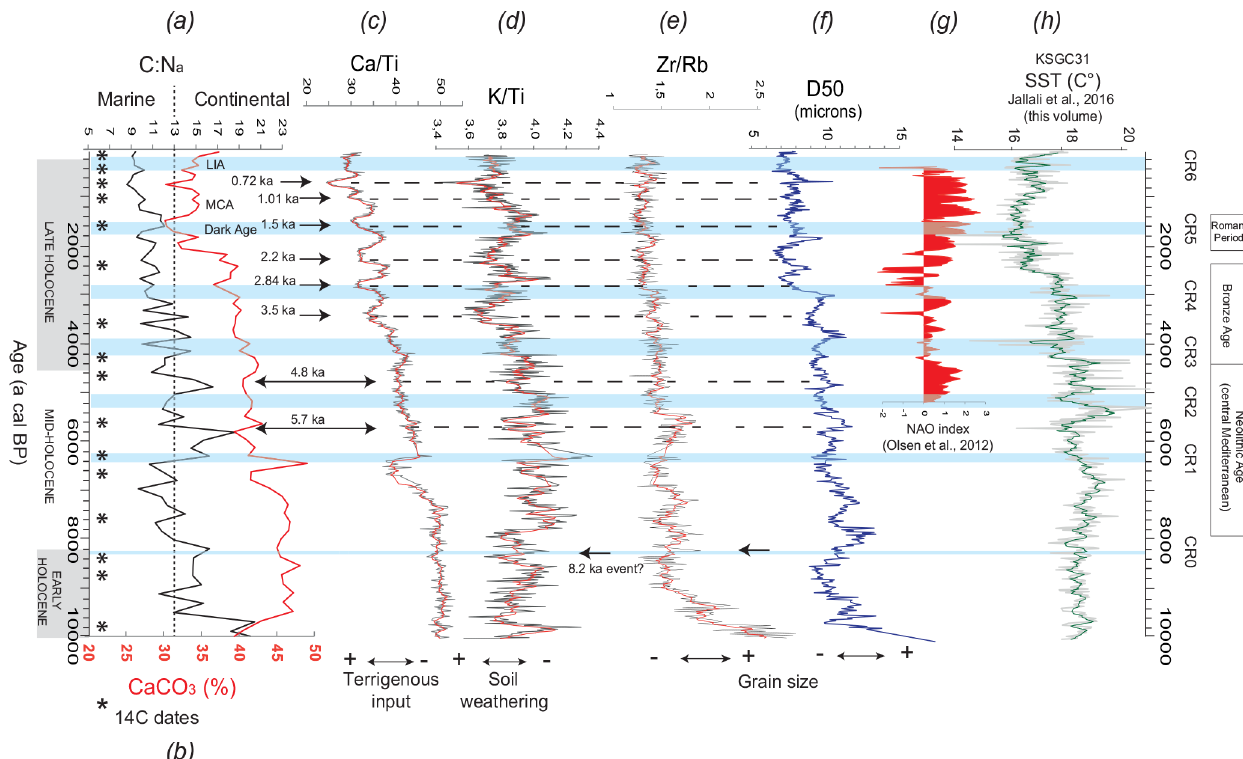
Figure 4. KSGC31 geochemical and sedimentological proxies. (a) C:N a atomic ratio is used as qualitative descriptor of organic matter nature. Values of C:N a ratio>13 indicate significant amount of terrestrial organic matter, according to Goñi et al. (2003). (b) CaCO 3 content (%) calculated from TC − OC using the molecular mass ratio (CaCO 3 : C = 100:12). (c) Ca / Ti ratio is used for estimating the degree of detritism, since Ti is commonly found in terrigenous sediments. (d) K / Ti ratio can be related to illite content, formed by weathering of K-feldspars. Illite may be depleted in K upon pedogenetic processes; the K / Ti ratio can be considered an indirect proxy for the intensity of chemical weathering (Arnaud et al., 2012). (e) Zr / Rb is known to reflect changes in grain size; Zr is commonly associated with the relatively coarse-grained fraction of fine-grained sediments, whereas Rb is associated with the fine-grained fraction. (f) D50 represents the maximum diameter of 50% of the sediment grain size. These plots are correlated to the reconstruction of North Atlantic Oscillation (NAO) (g) from a lake in Greenland (Olsen et al., 2012) and reconstructed SST (C ◦ ) from alkenones (h) in the same core (Jalali et al., 2016). Blue bands correspond to CR0-6 chronology; dotted black lines highlight the main wet events that may be observed in sediment records in the late Holocene (Table